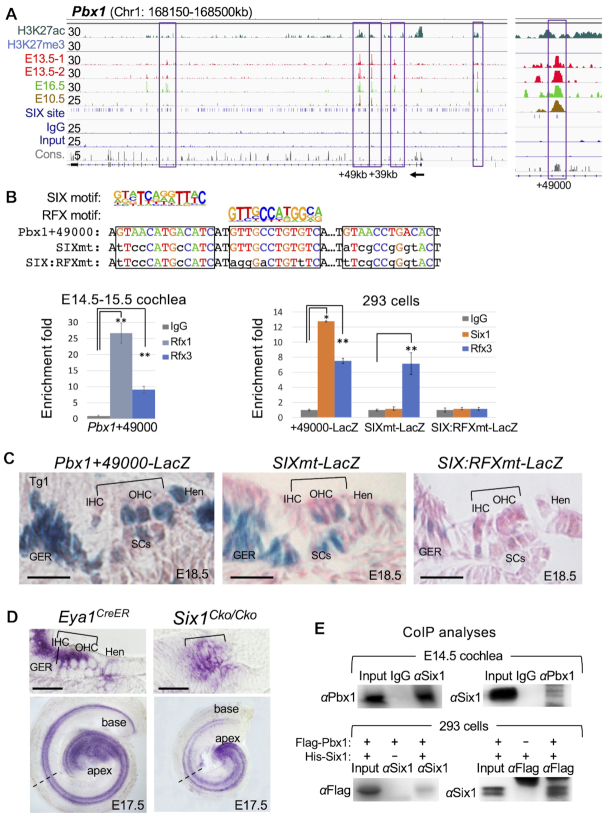
Dependence of a distal Pbx1 enhancer activity on co-binding of Six1 and Rfx1/3 through SIX:RFX motifs. (A) Genomic browser visualization of multiple Six1-bound regions at the Pbx1 and enlarged view of the intronic peak at ∼49-kb downstream from the TSS. (B) Pbx1+49 000 contains two SIX-motifs separated by a RFX-motif. ChIP-qPCR using chromatin from E14.5–E15.5 cochlear epithelium shows strong binding with Rfx1 and relative weaker binding with Rfx3. A 510-bp fragment of Pbx1+49000 driving LacZ reporter transgene and two mutant reporter transgenes were generated by introducing mutations into the predicted SIX-motifs or both SIX:RFX-motifs in combination. These reporters were assessed by ChIP-qPCR using chromatin prepared from 293 cells cotransfected with His-Six1 expression plasmid and reporter Pbx1+49 000, Pbx1+4900SIXmt or Pbx1+49000SIX:RFXmt. These mutations abolished Six1 or Rfx3 binding. Transfection was repeated three times and qPCR was performed in triplicates for each independent experiment. Input was used for normalization (see Materials and Methods) and the enrichment of mock IP was considered 1-fold. *P < 0.05, **P < 0.01. (C) G0 transgenic analysis of LacZ transgene driven by a 510-bp of Pbx1+49 000 showing activity in the sensory epithelium and flanking GER and Hensen's (Hen) ells (n = 7/7 transgenic embryos), while Pbx1+49 000SIXmt (n = 3/3 transgenic embryos) or Pbx1+49000SIX:RFXmt (n = 8/8 transgenic embryos). Brackets indicate the organ of Corti. (D) In situ hybridization of E17.5 Eya1CreER or Six1Cko/Cko (Eya1CreER;Six1fl/fl, tamoxifen given at E12.5). Top panels, sections of whole-cochlea shown in bottom panels indicated by dashed lines. Brackets indicate the organ of Corti. (B) Genomic browser visualization of multiple Six1-bound regions at the Pbx1 and enlarged view of the intronic peak at ∼49-kb downstream from the TSS. (E) CoIP analysis of nuclear extracts from E14.5 cochleae or 293 cells transfected with Flag-Pbx1/His-Six1. Other abb.: GER, greater epithelial ridge; IHC, inner hair cell; Hen, Hensen's cells; OHC, outer hair cell; SCs, supporting cells. GER, greater epithelial ridge. Scale bars: 30 μm.